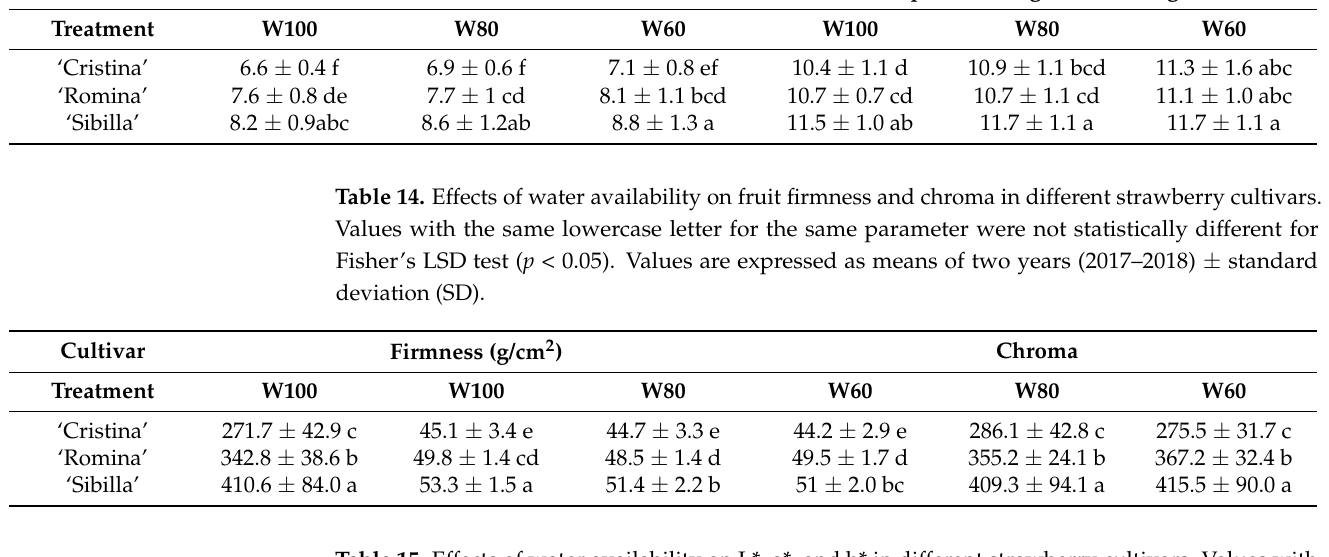
Table 15. Effects of water availability on L*, a*, and b* in different strawberry cultivars. Values with the same lowercase letter for the same parameter were not statistically different for Fisher’s LSD test ( p < 0.05). Values are expressed as means of two years (2017–2018) ± standard deviation (SD). L* a*